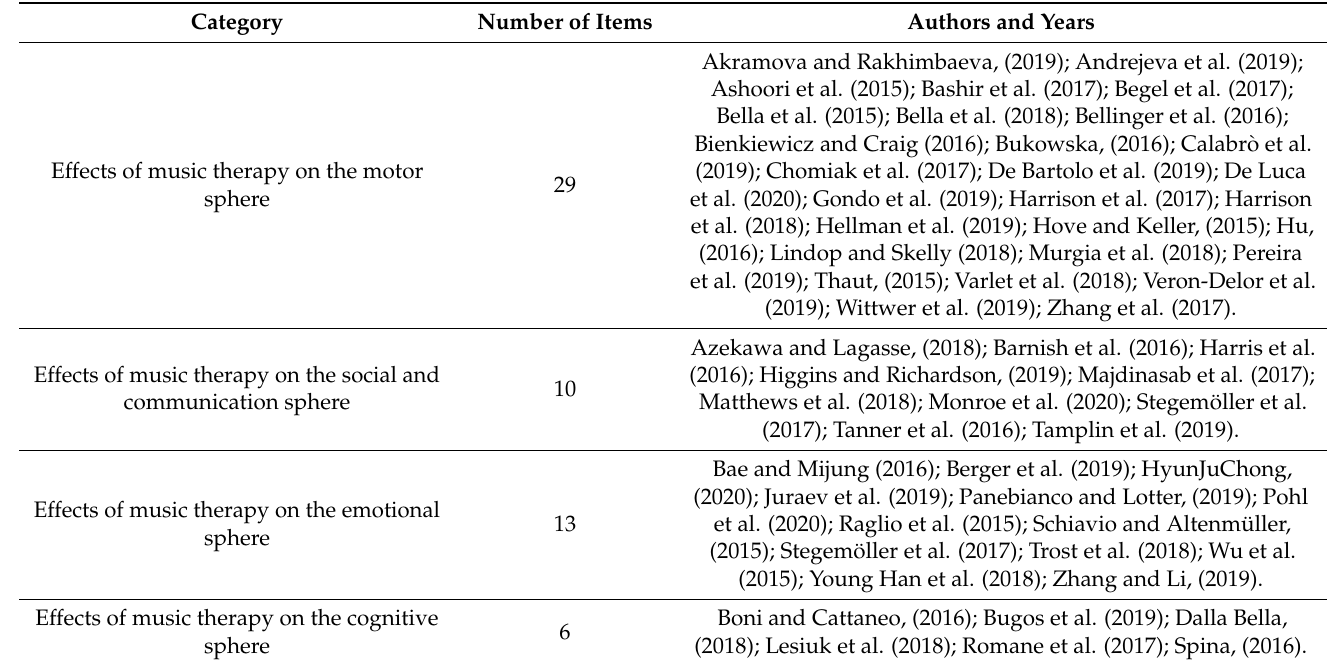
Table 3. Categories of analysis of the scientific literature and number of published articles.